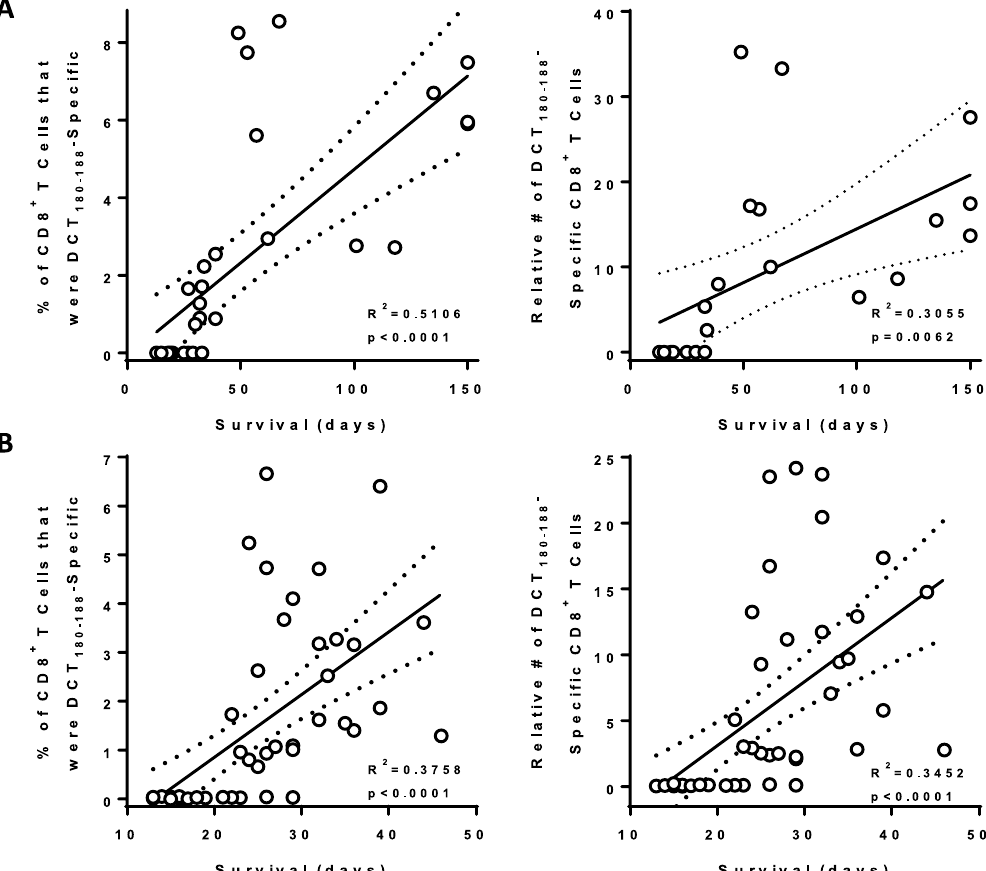
Figure 1. Survival correlated with the magnitude of antigen-specific blood-derived CD8 + T-cell responses in prophylactic and therapeutic models of metastatic brain cancer. Female C57BL/6 mice had 1,000 B16- F10 melanoma cells stereotactically implanted into the parenchyma of the right hemisphere of the brain. ( A ) Eleven days prior to, or ( B ) five days after intracranial challenge, mice were vaccinated intramuscularly with 1 × 10 8 pfu of recombinant human serotype 5 adenovirus expressing the melanoma-associated antigen dopachrome tautomerase, with injections administered into the semitendinosus of both hind limbs. Blood- derived CD8 + T cells specific for the immunodominant self-epitope DCT 180–188 were quantified fourteen days post-vaccination by flow cytometric assessment of intracellular cytokine staining after ex vivo re-stimulation with peptides (supplementary Figure 1). Pearson correlation analysis was performed for overall survival versus frequency (left panel; n = 33 for [A] and 52 for [B]) and total number (right panel; n = 23 for [A] and 52 for [B]; pooled from five and ten experimental replicates, respectively) of antigen-specific CD8 + T cells. Lines of best fit with 95% confidence intervals are